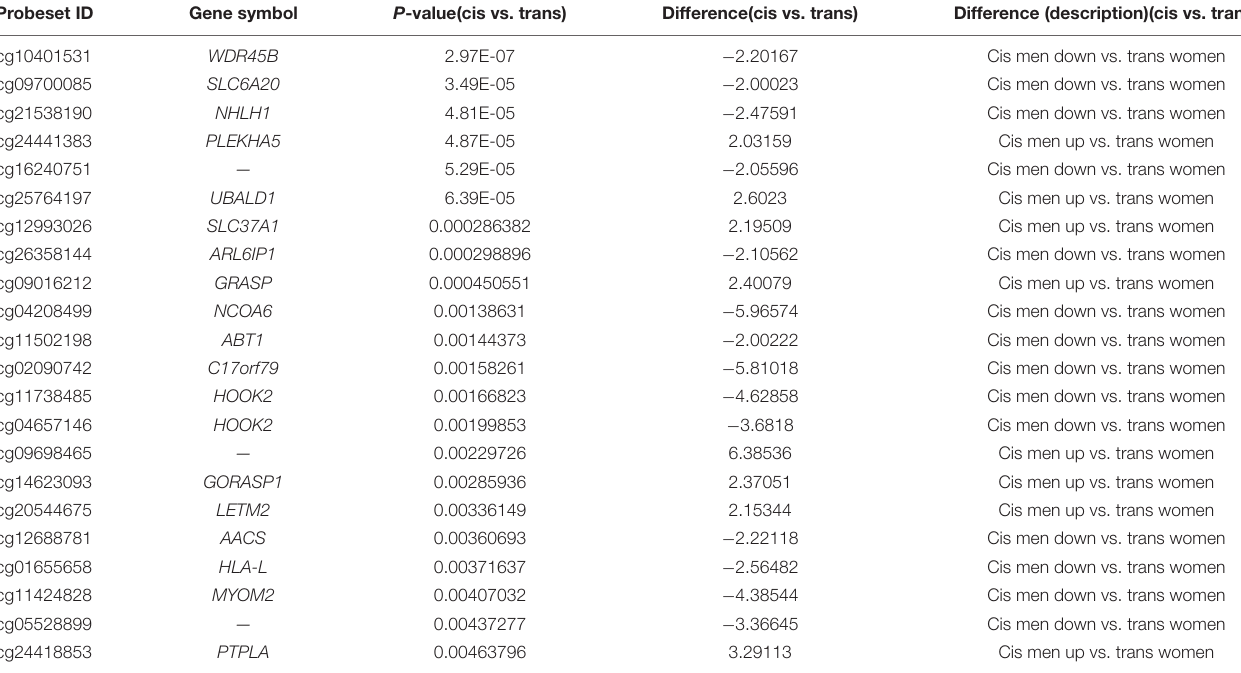
TABLE 1 | The 22 CpG islands that passed statistical correction (FDR p < 0.05; fold change ≥ 2.0), in the population assigned male at birth. Probeset ID Gene symbol P -value(cis vs. trans) Difference(cis vs. trans) Difference (description)(cis vs. trans)